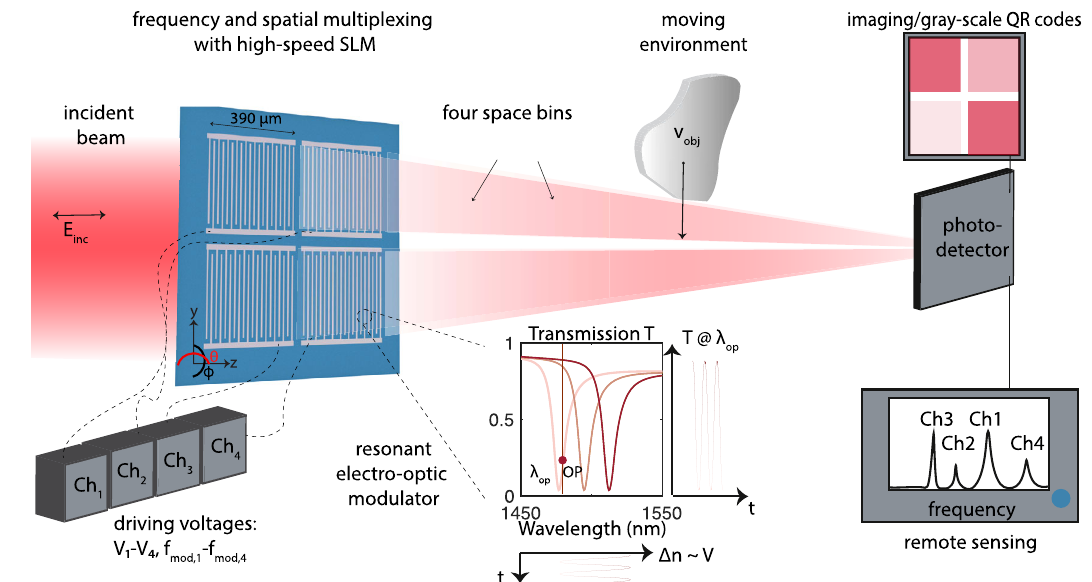
Fig. 1 Large area, high-speed, electro-optic spatial light modulator for massively parallel imaging or remote sensing. A beam of light E inc is incident onto an array of n × n electro-optic modulators that are controlled by a set of driving voltages V n at radio-frequencies f mod ; n . The modulators are resonant by design and covered by a single layer of electro-optic molecules (see inset transmission function). Consequently, their resonant wavelength can be shifted by the external driving voltages through the electro-optic (Pockels) effect that changes the refractive index of the modulators by Δ n ~ V n . When the incident beam oscillates at a given operation (OP) wavelength λ op , the transmission is modulated by the voltage (see correspondence between V, Δ n , and T). In an imaging experiment, the spatial and temporal control over the incident light achieves gray-scale QR codes in its far- fi eld. In a remote sensing experiment, the ability to modulate each pixel with an unique frequency f mod ; n allows to link the RF domain with well-de fi ned space bins. As a result, while performing a single-pixel detection of all channels at one single high-speed photodiode, a multipixel map of the environment is reconstructed by tracking, in parallel, the amplitudes of the individual transmitted modulation frequencies and their evolution over time. SLM spatial light modulator, Ch channel, QR quick